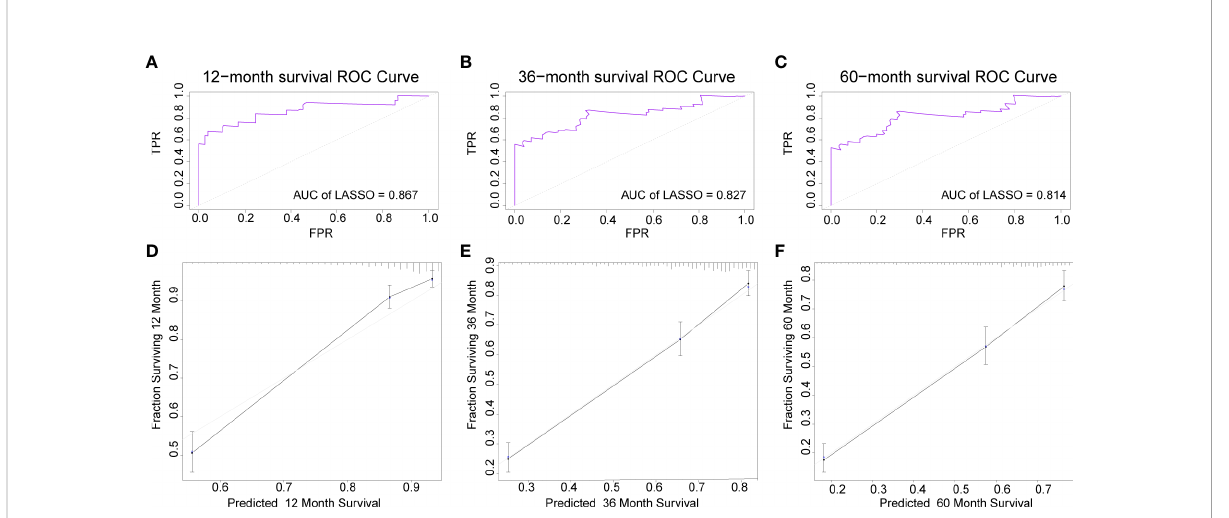
FIGURE 7 The AUC and calibration curves of DL survival Cox model at 1-, 3-, 5-years in the validation set. (A – C) , the AUC of model at 1-, 3-, 5-years. (D – F) , the calibration curves of model at 1-, 3-, 5-years. AUC, area under the curve; DL, deep learning.